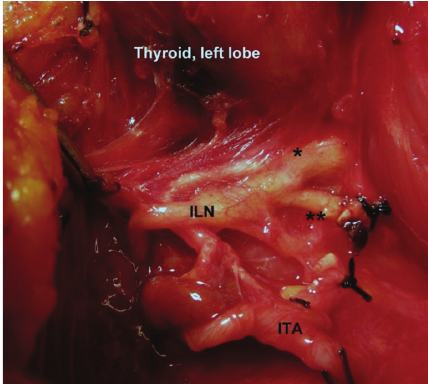
Figure 5: Terminal division of the left inferior laryngeal nerve (ILN) occurs at pre-laryngeal segment (Type 3). ∗ Anterior branch. ∗∗ Posterior branch. ITA: inferior thyroid artery.